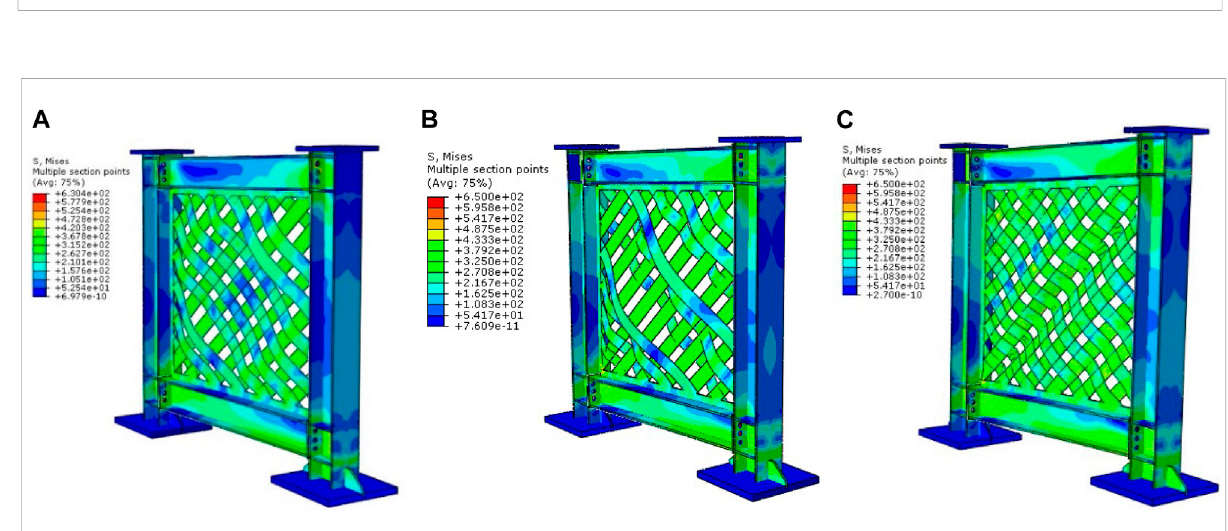
FIGURE 20 The Von-Mises stress and the post-buckling response of the parametric models: (A) Test, (B) SW-1, and (C) SW-2 model.